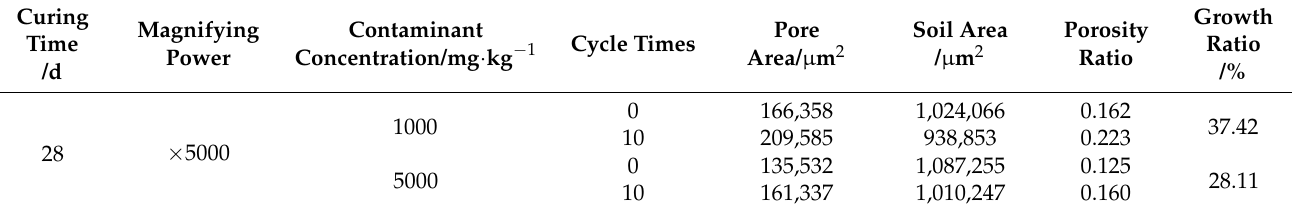
Table 5. Porosity ratio of specimens under different durability conditions at the age of 28 d.